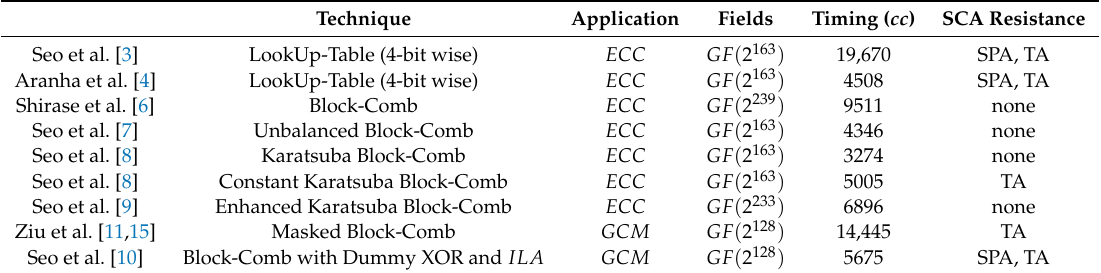
Table 1. Comparison of existing multiplication methods over binary fields on 8-bit AVR